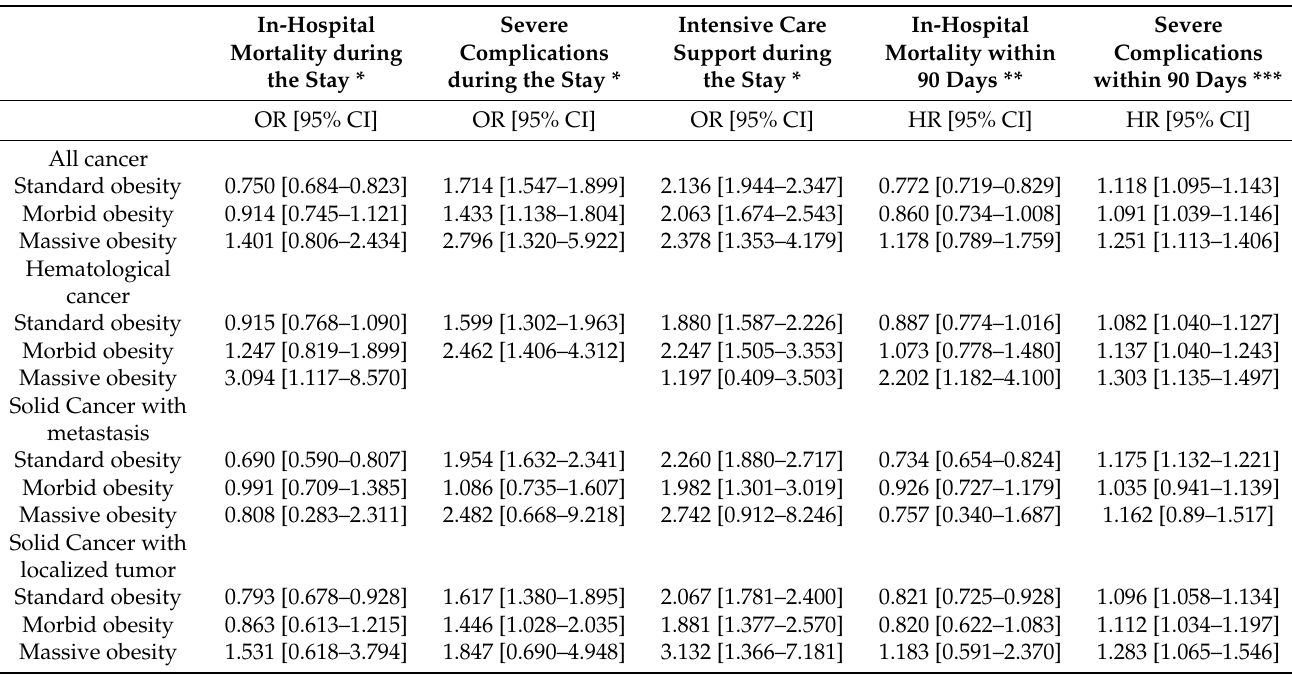
Table 5. Effect of obesity according to its severity and by type of cancer on the different outcomes, among COVID-19 cancer